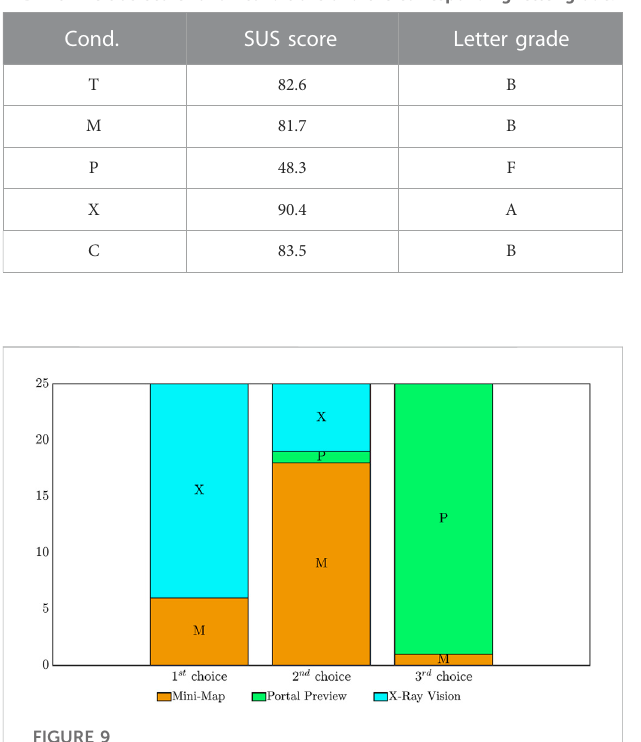
FIGURE 9 Ranking of the techniques based on participants ’